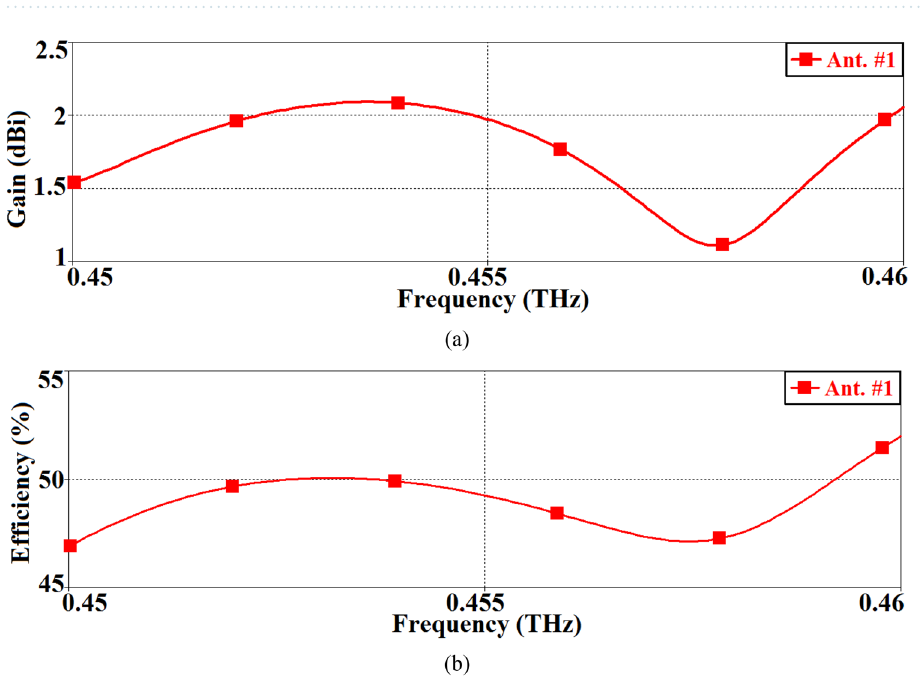
Figure 4. The measured radiation properties of the of the SIW inspired AoC (Ant. #1), ( a ) gain, and ( b ) radiation